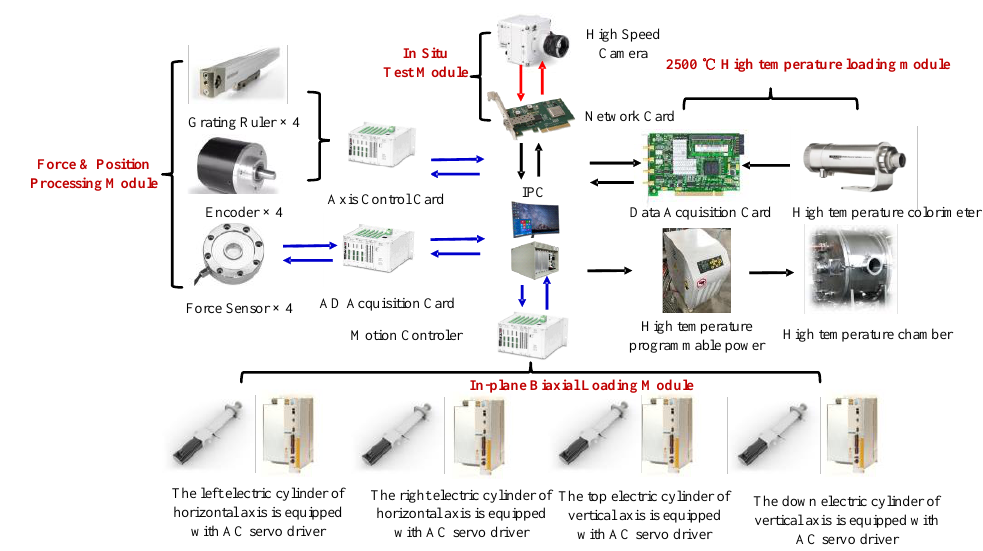
Figure 6. Detailed design scheme of the motion control apparatus.